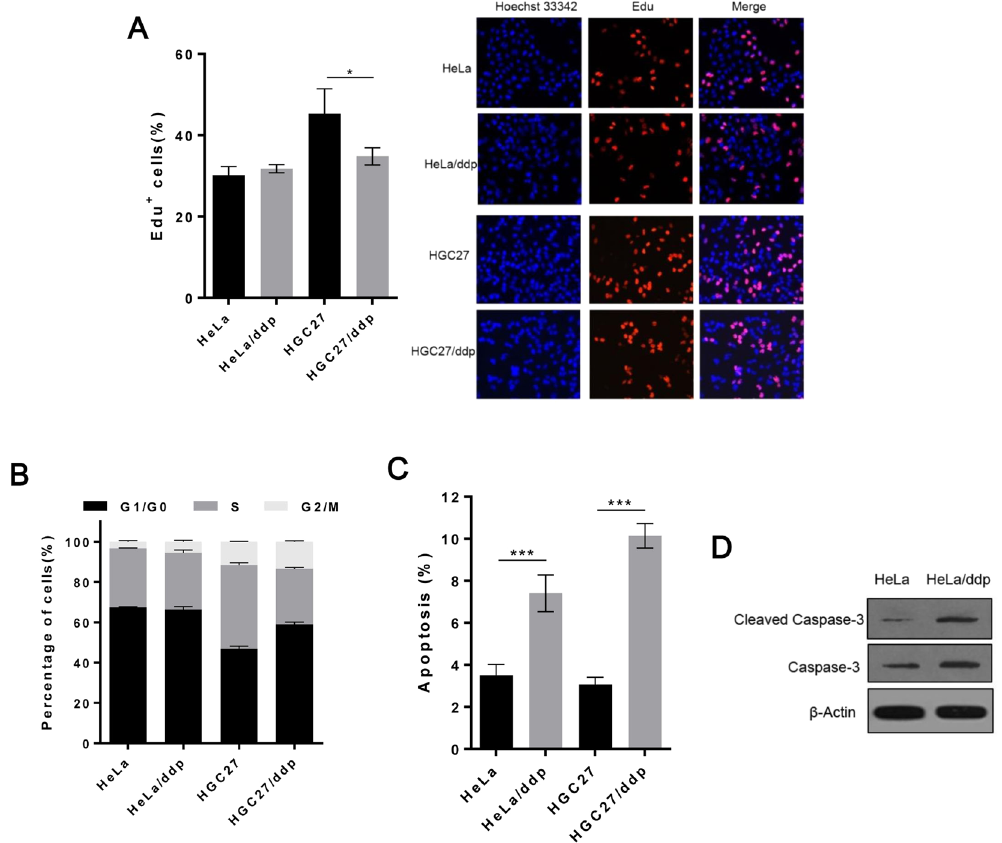
Figure 2. The apoptosis rate is increased in ddp-resistant cells. ( A ) EdU assay of HeLa, HeLa/ddp, HGC27 and HGC27/ddp cells. The medium was replaced with normal medium on the following day. The EdU assay was performed 48 h after medium replacement. ( B ) Cell cycle analysis of HeLa, HeLa/ddp, HGC27 and HGC27/ ddp cells. The medium was replaced with normal medium on the following day. The cell cycle distribution was analyzed 48 h after medium replacement. ( C ) Apoptosis of HeLa, HeLa/ddp, HGC27 and HGC27/ddp cells under the indicated conditions. The medium was replaced on the following day with normal medium. Apoptosis rate was analyzed 72 h after medium replacement. ( D ) Western blot analysis of cleaved caspase-3, and caspase-3 protein expression in HeLa and HeLa/ddp cells using different antibodies, β -Actin was used as a loading control. The error bars represent the s.d. of triplicate wells of a representative